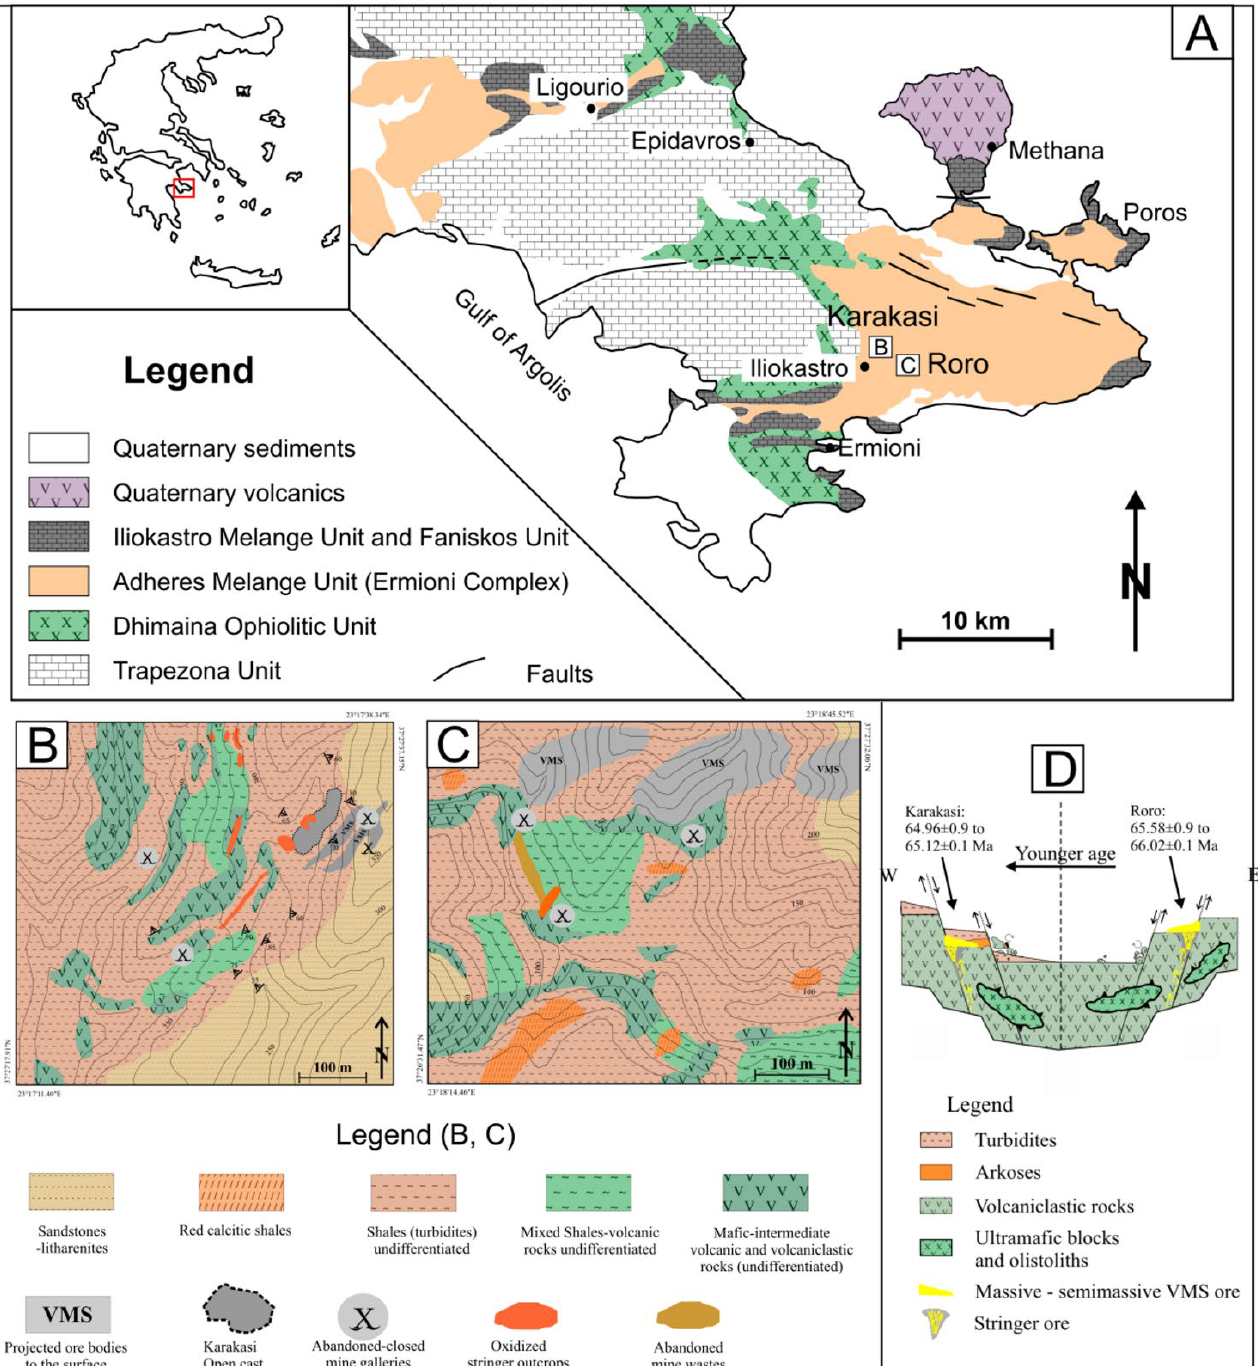
Figure 1. ( A ) Simplified geologic map of Argolis Peninsula with the locations of the major Ermioni VMS sites (with modifications after [27,35]), ( B , C ) geology of Karakasi and Roro mining sites (with modifications after[28,36,37]), ( D ) Simplified geologic map of Ermioni basin in upper Cretaceous during Roro and Karakasi VMS formation (with modifications after